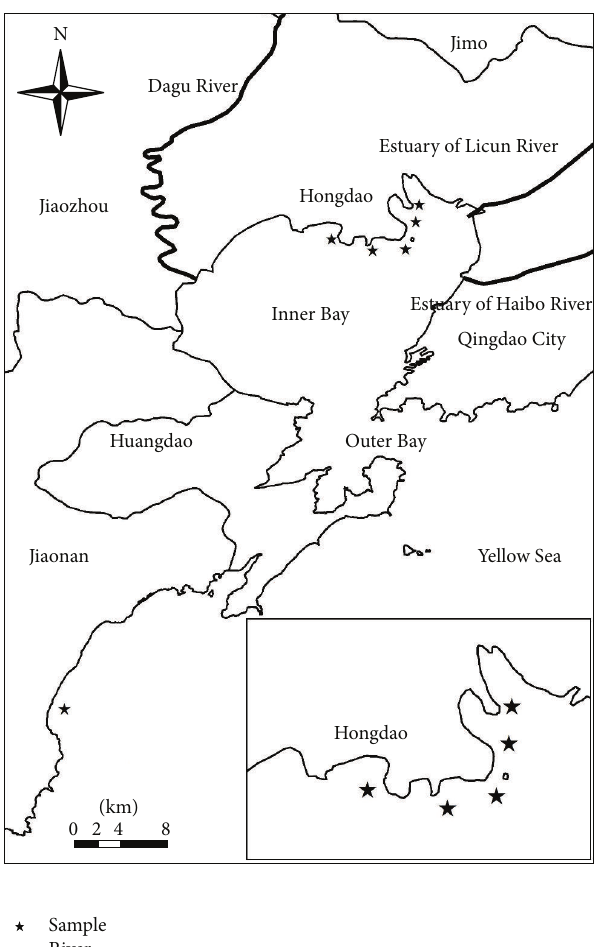
Figure 1: The spatial location for shellfish sampling in Jiaozhou